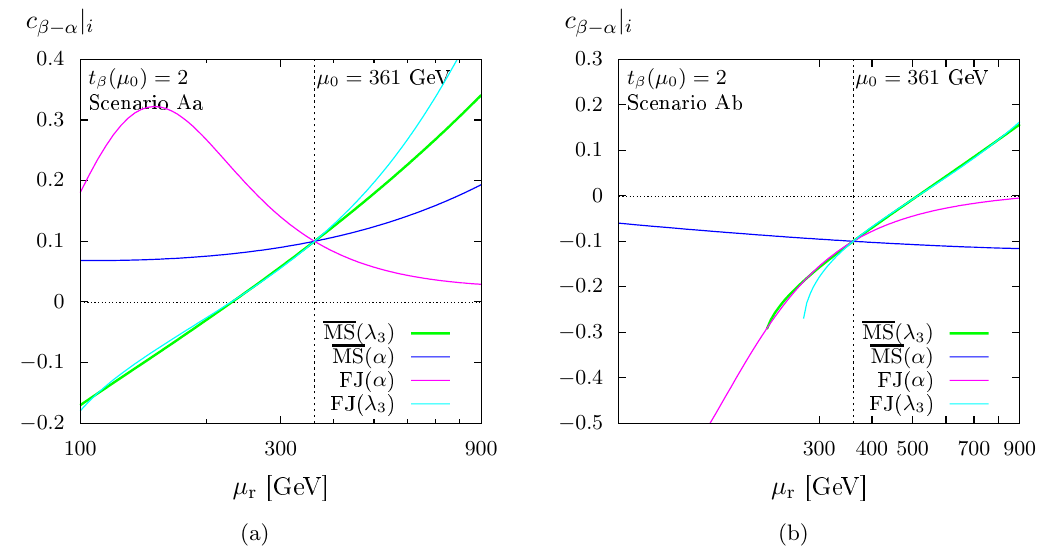
Figure 9 . The running of c (cid:12) (cid:0) (cid:11) for scenarios Aa (a) and Ab (b) in the MS( (cid:11) ) (blue), MS( (cid:21) (green), FJ( (cid:11) ) (pink), and FJ( (cid:21) 3 ) (turquoise)